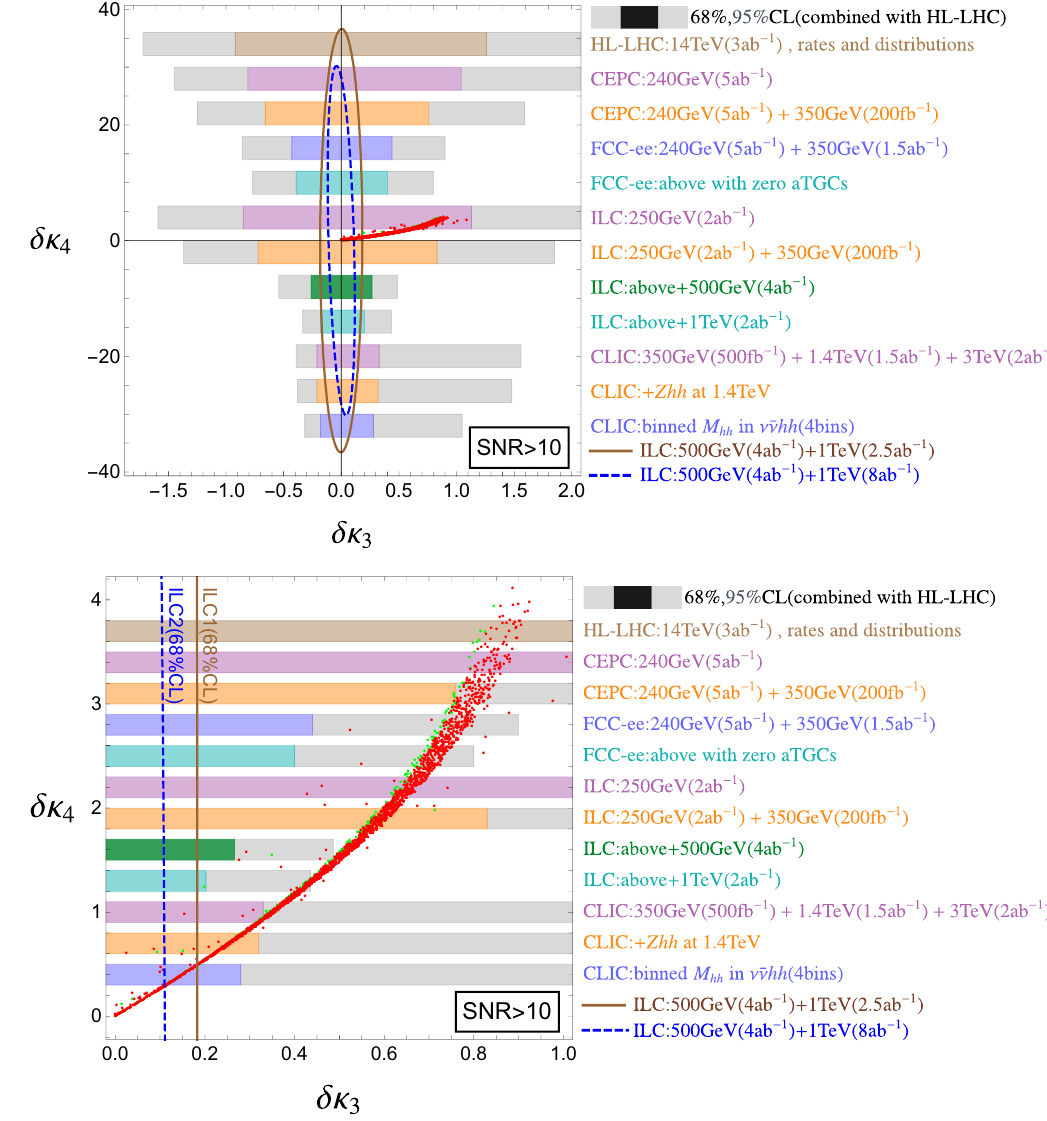
Figure 10 . The Higgs cubic and quartic couplings ((cid:1) (cid:20) 3 ; (cid:1) (cid:20) 4 ) for parameter space points giving detectable GW. Here the green points give SNR > 10 and the red gives SNR > 50. The bars denote the sensitivity of (cid:1) (cid:20) 3 from a global analysis of future colliders in ref. [75], for various detector scenarios shown on the right side of the (cid:12)gures. The brown solid and blue dashed lines are the 1 (cid:27) contours for two di(cid:11)erent ILC scenarios taken from ref. [79]. The bottom panel is a zoomed-in version of the top